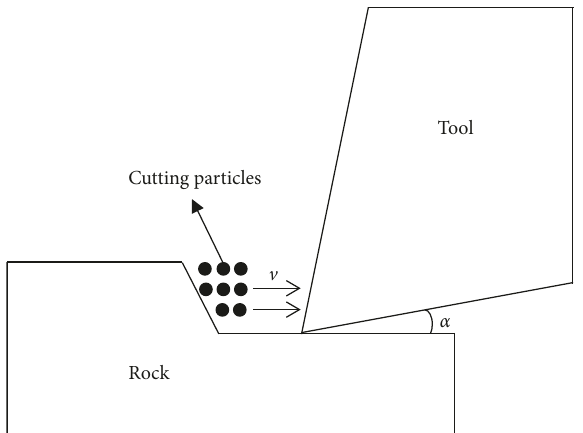
Figure 13: Schematic of the impacts of the cutting particles on the rack face.